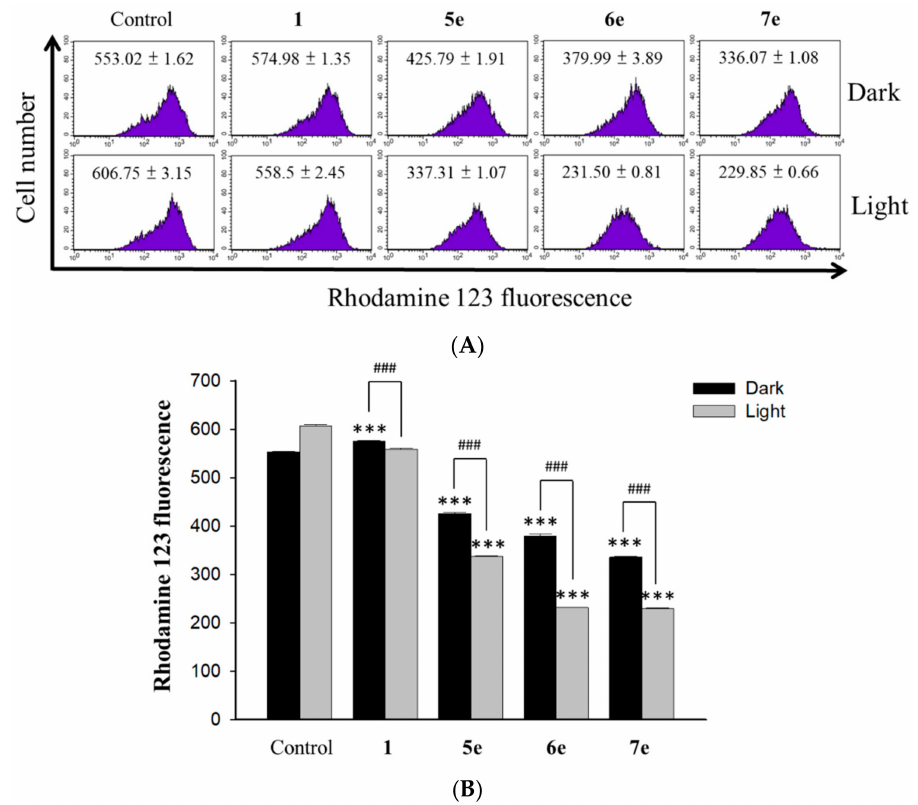
Figure 9. Measurement of the mitochondrial membrane potential. ( A ) HepG2 cells (1 × 10 5 cells / mL) were incubated with 0.5 µ M concentration of berberine ( 1 ) and its derivative 5e , 6e and 7e at 0.25 µ M concentration for 2 h upon visible light irradiation (420 nm, 10 min) for 24 h and then stained with 2 mg / mL of Rh123 for 20 min under gentle shaking. After washing with PBS, cells were immediately analyzed by flow cytometry and data were analyzed using the FCS Express software. ( B ) Average intensity of RH123 fluorescence in HepG2 cells treated with 0.5 µ M of berberine ( 1 ) and its derivatives 5e , 6e and 7e at 0.25 µ M concentration. The results are presented as mean ± SD. *** p < 0.001 compared with control, ### p < 0.001 compared with dark